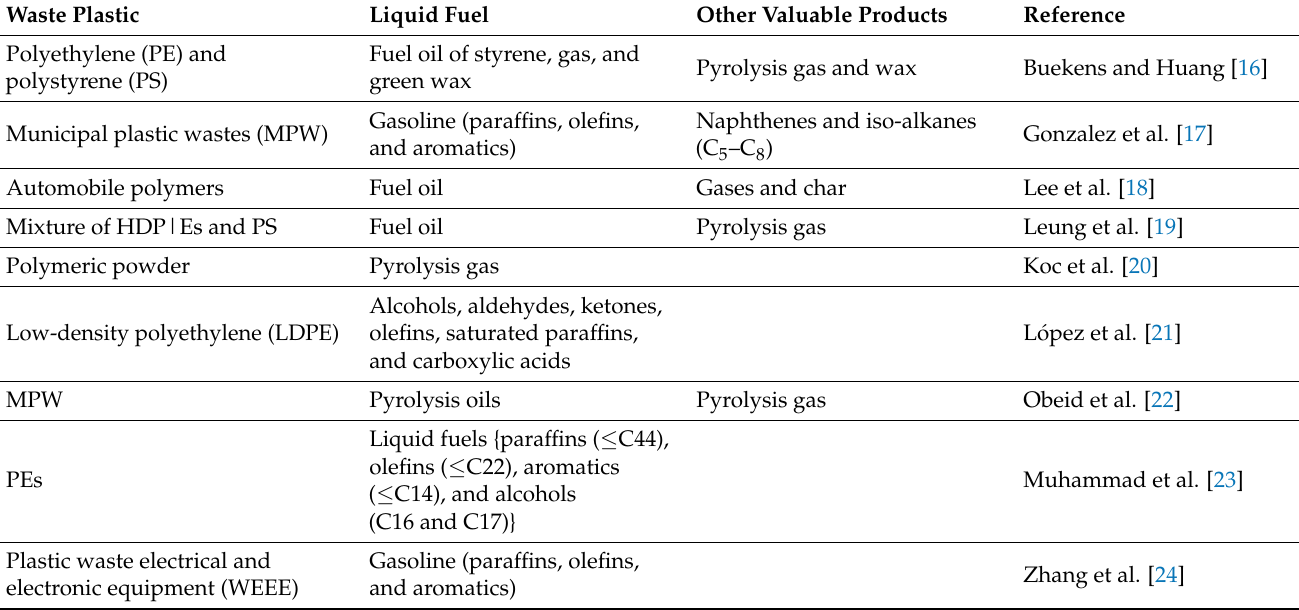
Table 1. Common waste plastic pyrolysis products with fuel oil being highly